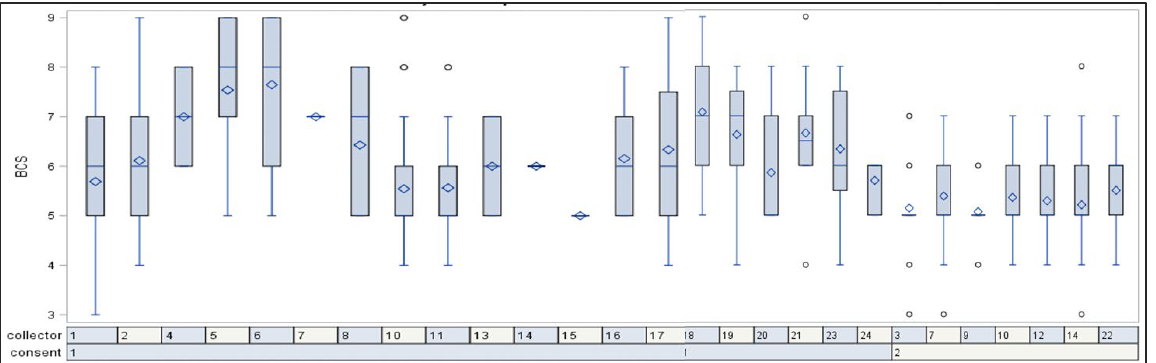
Figure 2. Kruskal–Wallis plot, distribution of BCS for data collectors’ profession. 1: Veterinarians, 2: Feed consultants, 3: Farriers, 4: Equine therapists, 5: Trainers, 6: DEF officials ( p = 0.001). The box represents 50% of the scores for the group. The blue line in the box is the median, and the diamond is the mean. The upper and lower blue lines show the minimum and maximum values. Circles outside the lines represent outliers.